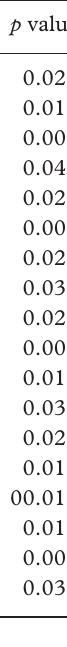
Figure 2. Learning activity qualifications Test means varied from a high score of 7.4 (CTC1, ‘Knowledge of student